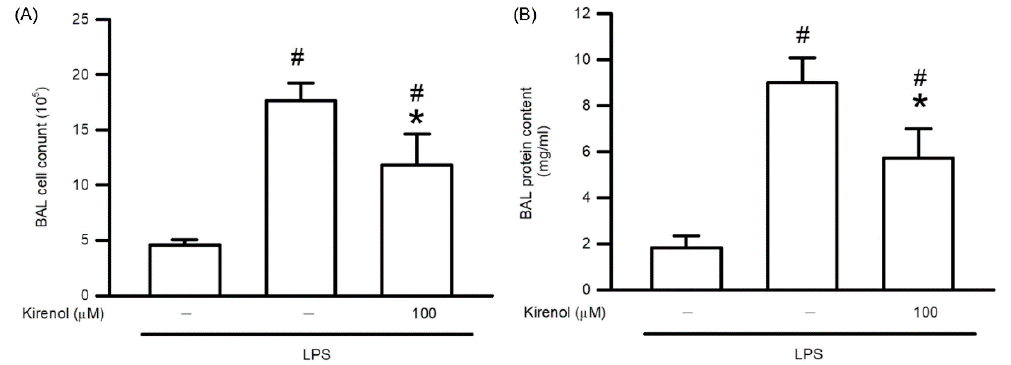
Figure 9. Kirenol suppressed the leukocyte infiltration and alveolar-capillary barrier disruption. ( A ) Leukocyte infiltration was determined by cell counter assay activity in BALF. ( B ) The contents of protein in BALF were measured by Bradford protein analysis. Values are shown the mean ± S.D. of 3–4 mice per group. # represents the significant difference compared with the Group A ( p < 0.05); * represents the significant difference compared with Group B ( p < 0.05).